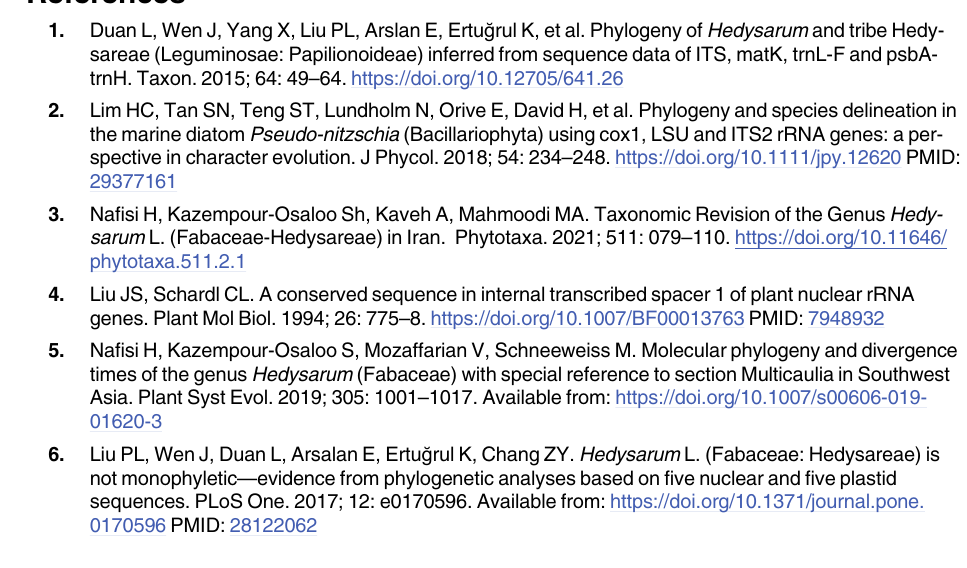
S11 Table. Inter-sectional aligned base changes in the secondary structure of 5.8S region. (DOCX) S12 Table. Diversity